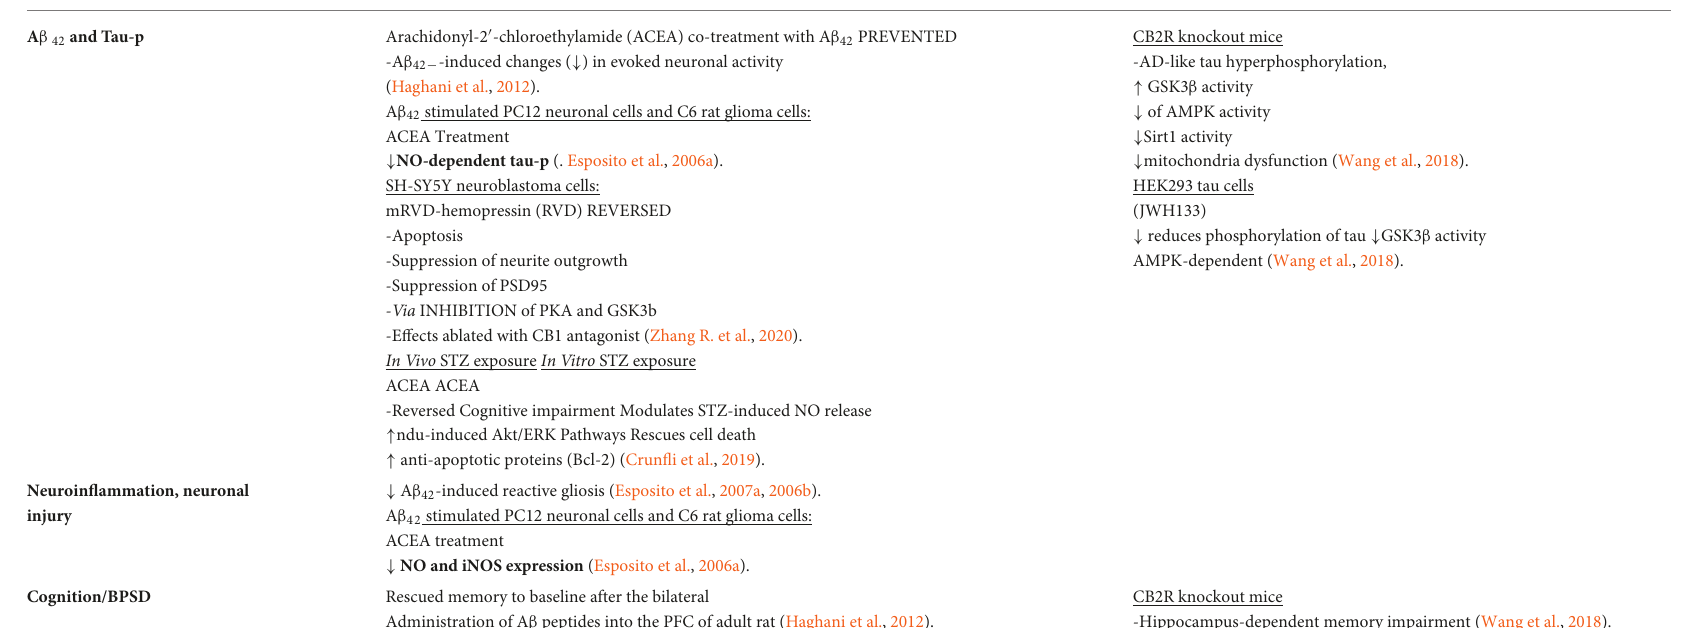
TABLE 5 Distinct contributions of CB1R or CB2R on in vitro /non-AD models of Alzheimer’s disease-related